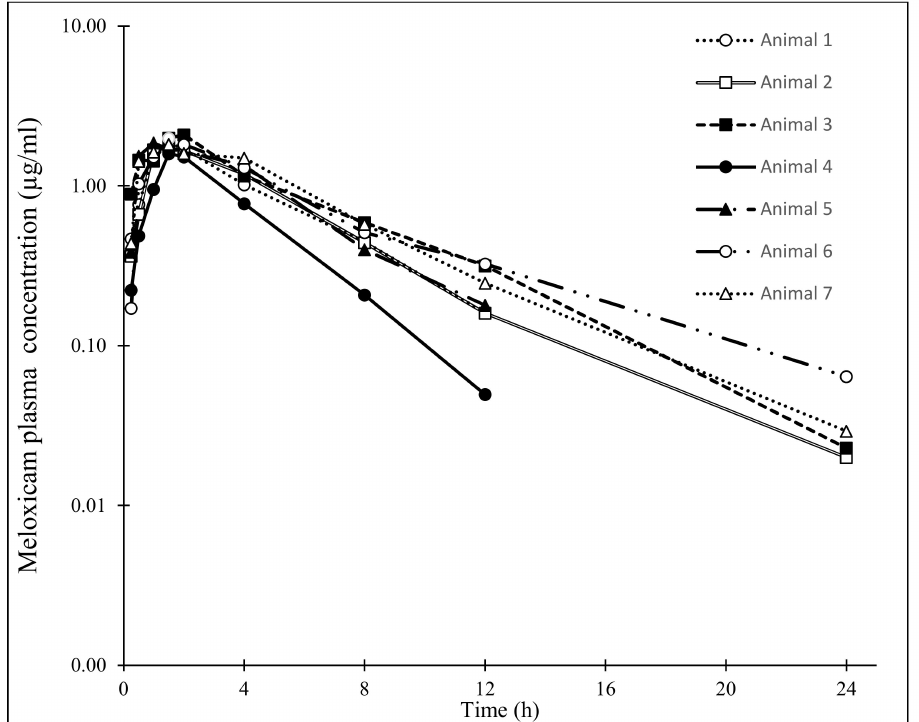
Figure 1. Individual plasma concentrations of meloxicam in undulate skates ( Raja undulata ) (n = 7) after a single IM administration (1.5 mg/kg). Please note the very similar kinetic curves among the different individuals. Meloxicam plasma concentration at 24 h in animals 1, 4 and 5 was under the limit of detection (0.02 µ g/mL); concentration at 48 h was under the limit of detection in all individuals.